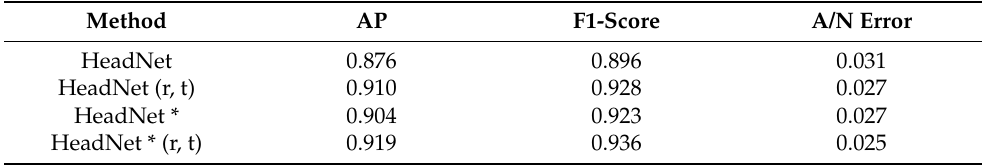
Table 2. Performance of HeadNet on test dataset.